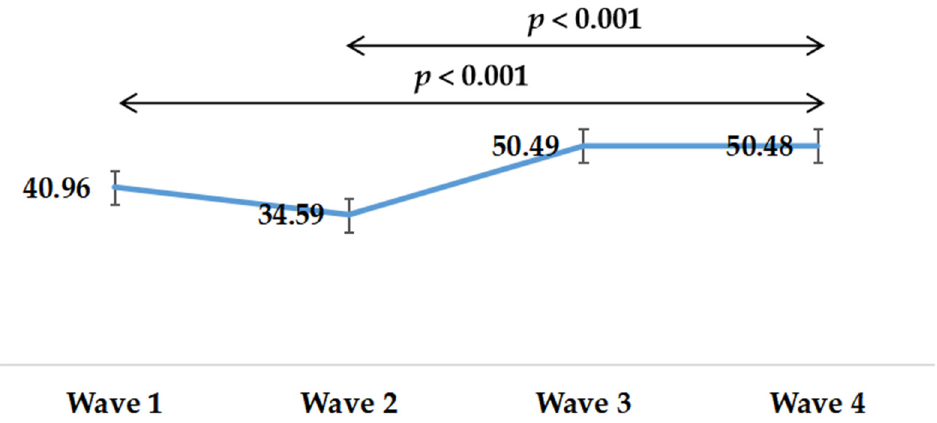
Figure 2. Changes in light physical activity in four waves during the COVID-19 pandemic. Changes in SB during the survey period can be observed in Figure 3. SB time presented a downward trend. SB time in Wave 1 was significantly more than that of Wave 4 ( p = 0.019).